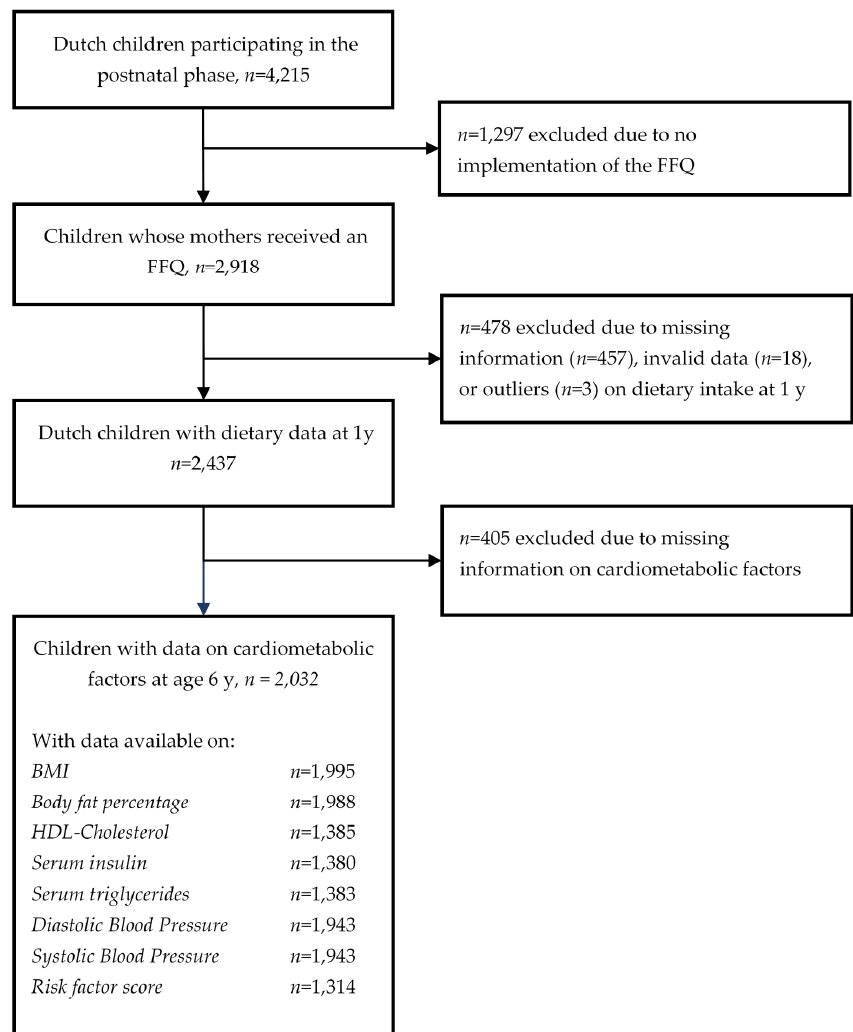
Figure 1. Flow chart of study participants included in the analysis.